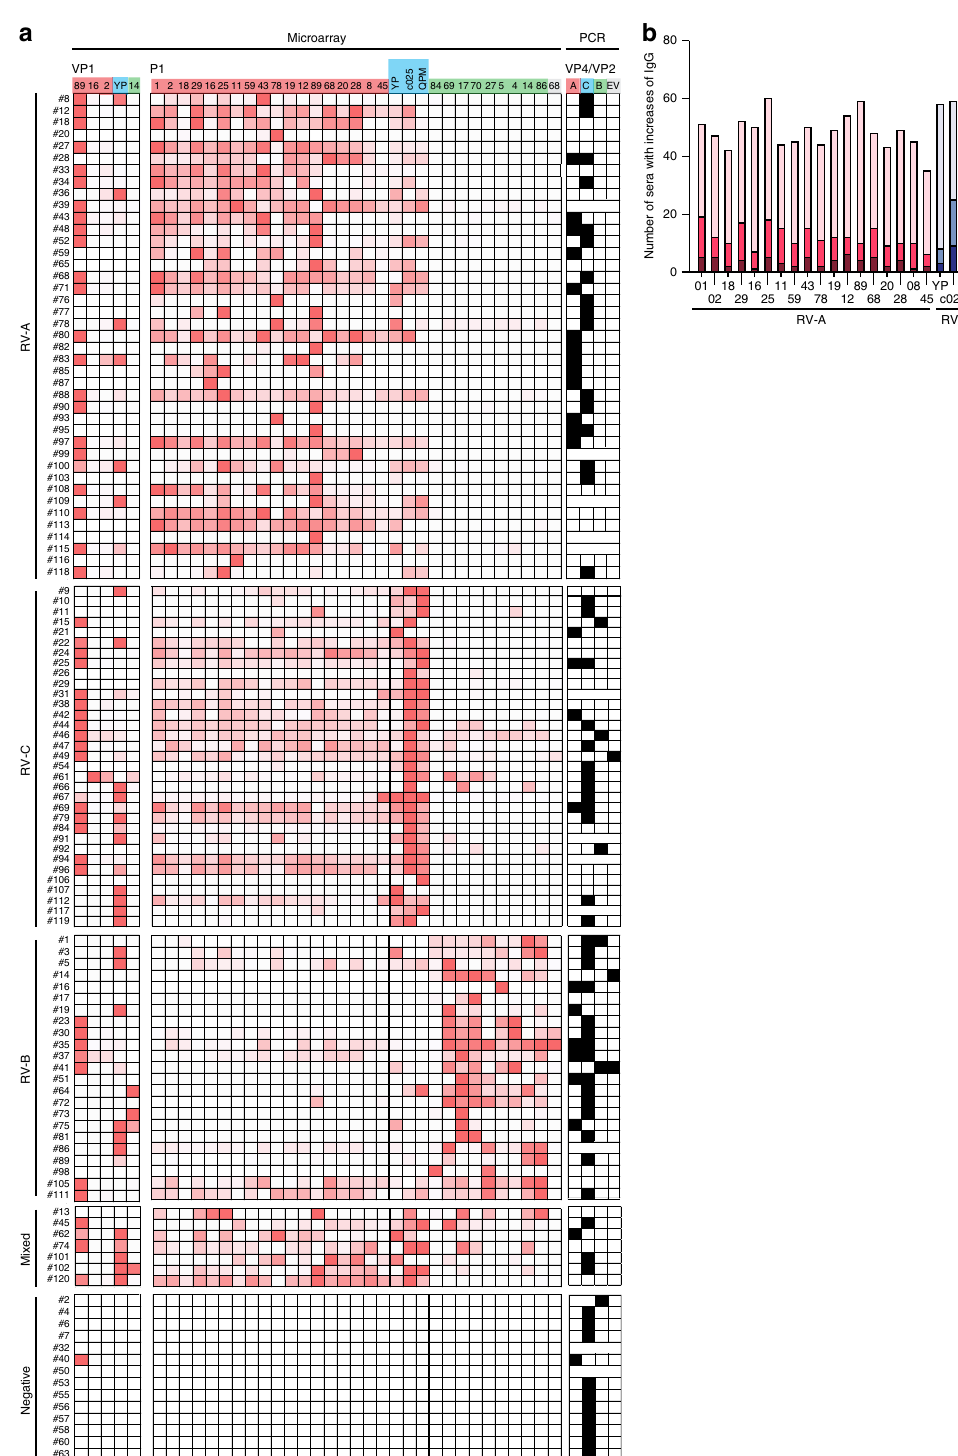
Fig. 3 Increases of IgG antibodies to N-terminal VP1 peptides detect culprit RV species. a A map showing IgG antibody increases (gradient color scale ranging from minimal to maximal value for each of the subject: white to dark red) to recombinant VP1 proteins and N-terminal VP1 peptides from three RV species (top lines RV-A: red; RV-C: blue; RV-B: green) measured by the microarray and PCR data for the wheezing children (white squares: PCR negative; black squares: PCR positive; no squares: not tested due to lack of samples). Shown are children for which RV-A ( n = 41), RV-C ( n = 33), and RV-B ( n = 23) were identi fi ed as culprit species according to chip analysis, as well as children with mixed ( n = 7) and no responses ( n = 15). b Absolute increases of IgG antibody levels between the acute and follow-up visit for the wheezing children ( y -axes: n , number of reactive sera) to the VP1 peptides ( x -axes: red: RV-A species; green: RV-B species; blue: RV-C species) are shown. Antibody increases are color-coded and expressed as ISAC standardized units